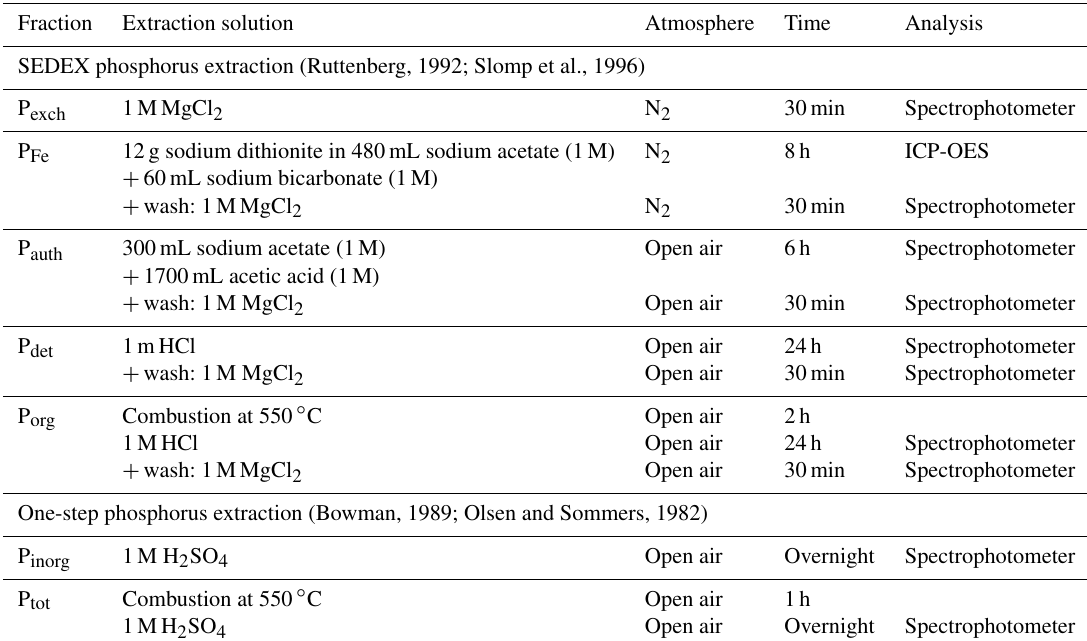
Table A2. Specifics for the sequential extractions of phosphorus. After the extraction, the sample was centrifuged (2500 g for 10min), and the supernatant was filtered (0.45µm cellulose acetate). ICP-OES: inductively coupled plasma optical emission spectrometry. Fraction Extraction solution Atmosphere Time Analysis SEDEX phosphorus extraction (Ruttenberg, 1992; Slomp et al.,